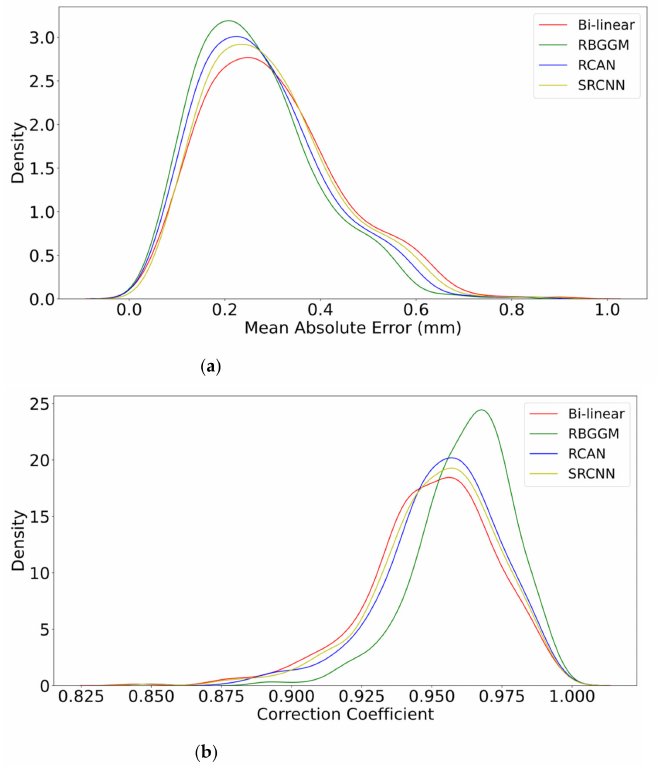
Figure 8. ( a ) PDF distribution of mean absolute error using four methods applied on the test set; and ( b ) PDF distribution of correlation coefficient using four methods applied on the test